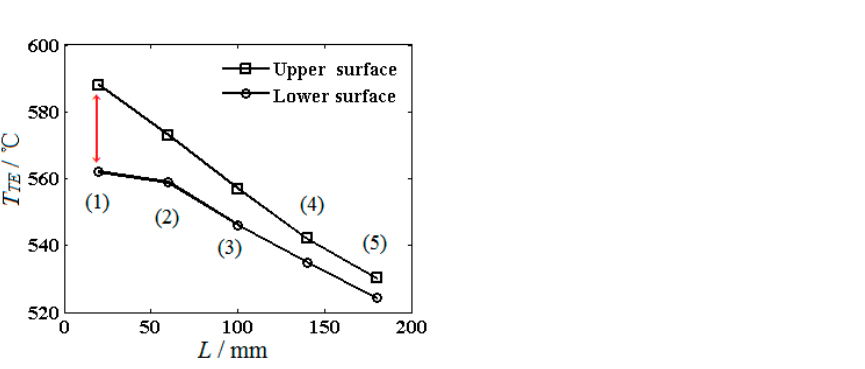
Figure 7. Both the hot side temperature and cold side temperature of the thermoelectric module decreased along the reactant flow direction. The hot side temperature decreased